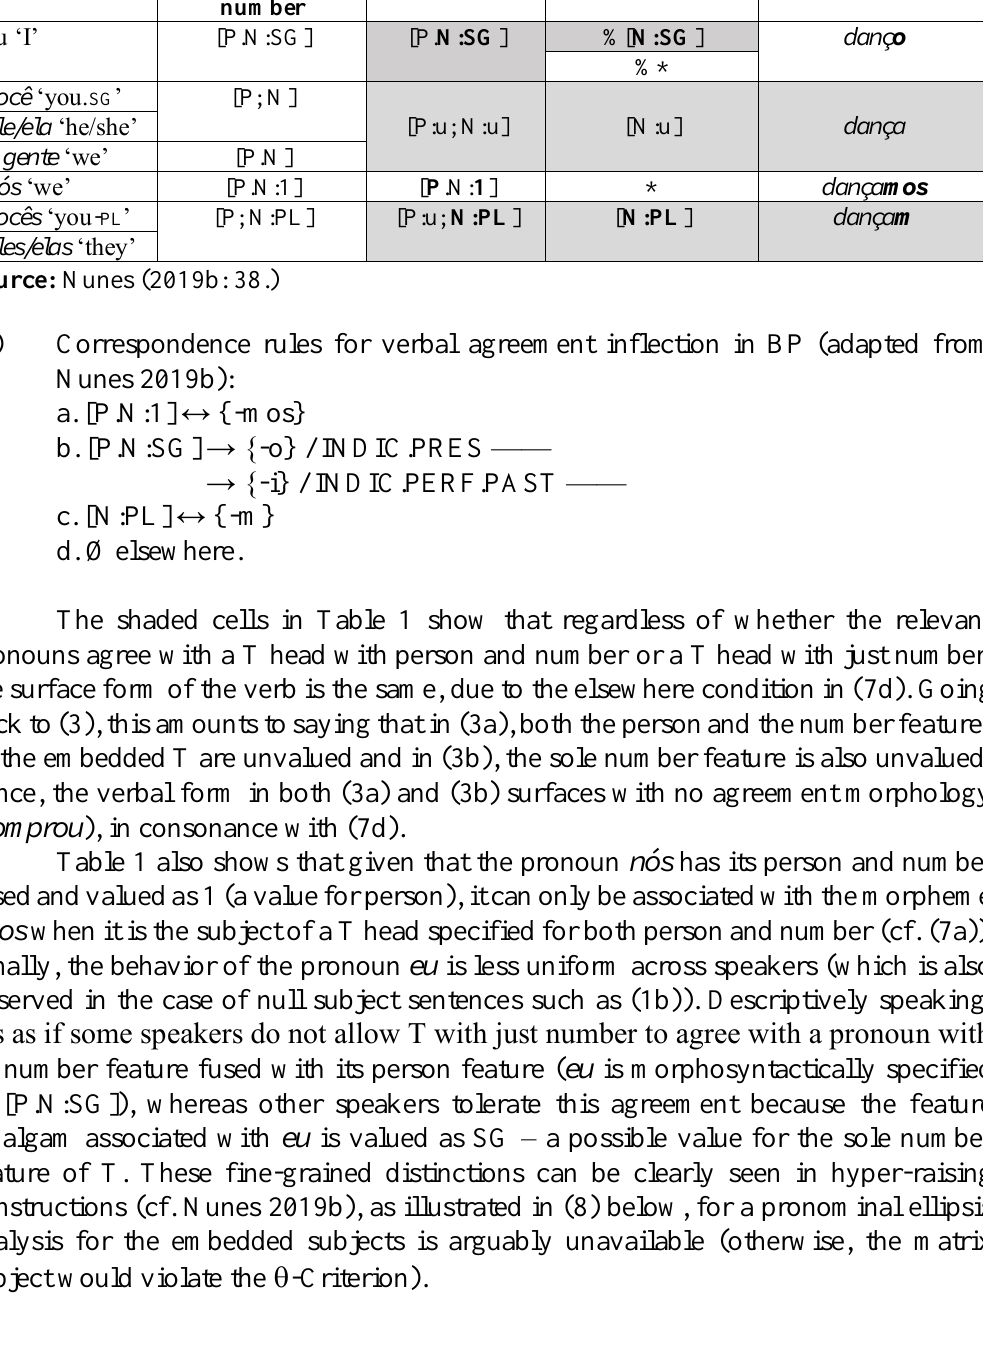
Table 1. Ambiguity of finite T in BP